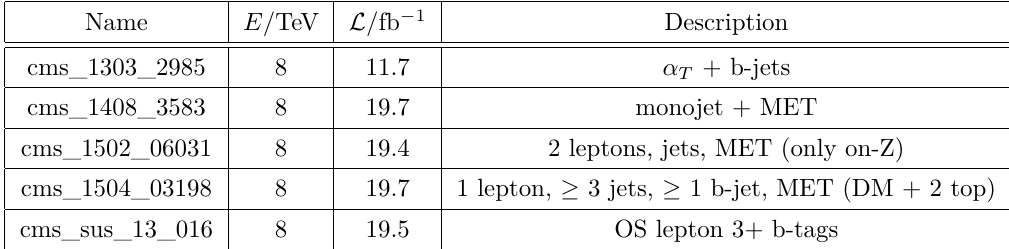
Table 9 . List of 8 TeV CMS analyses available in CheckMATE and which have been validated against published experimental results.